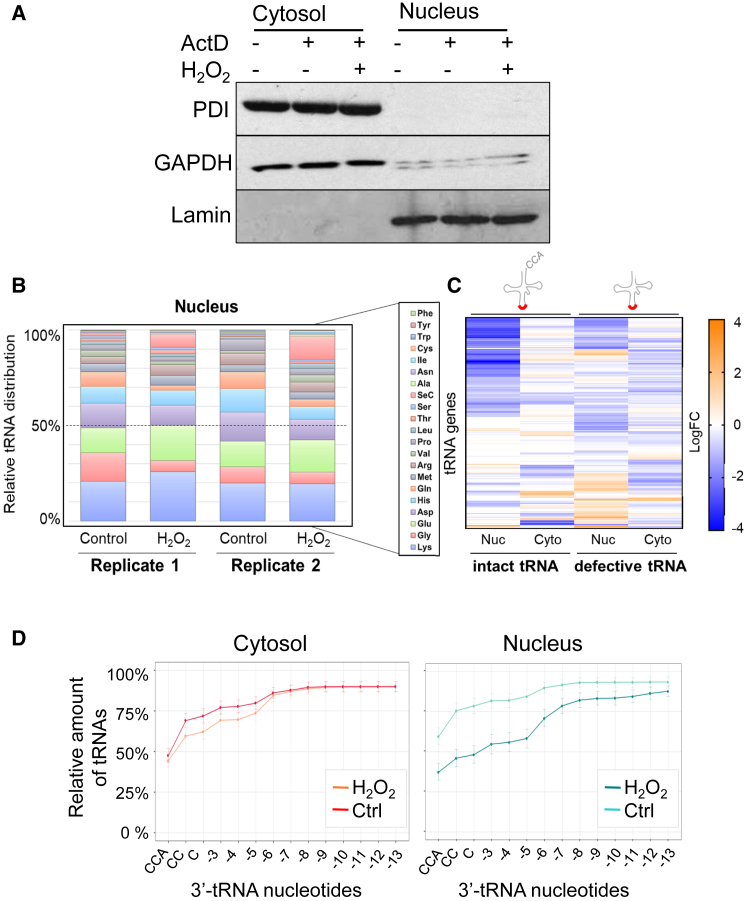
Oxidative Stress Induces Changes in the Overall Composition of the Cytosolic and Nuclear tRNA PoolsHeLa cells were treated with ActD in the presence or absence of 5 mM H2O2 for 2 h. Cells were fractionated into a nuclear and cytosolic fraction, RNA extracted from each fraction, and next-generation sequencing (TGIRT) of small RNAs was performed.(A) Western blot of nuclear and cytosolic fractions with antibodies detecting marker proteins for the nucleus and cytoplasm. GAPDH, glyceraldehyde 3-phosphate dehydrogenase; PDI, protein disulfide isomerase; lamin, lamin-B1.(B) Total RNA reads were mapped to 323 unique tRNA genes. All reads mapping to the same tRNA species were counted and combined, and their relative distribution was calculated. tRNAs were clustered according to their relative abundance in the nucleus.(C) Heatmap showing the Log2 fold change (Log2FC) of tRNA-specific reads in nuclear or cytoplasmic fractions of cells treated with H2O2 relative to untreated cells. tRNA-specific reads were mapped to the 3′ end of the tRNAs and sorted for intact tRNAs (with a full 3′ CCA end) and defective tRNAs (with an incomplete 3′ end). A threshold base mean of more than 20 reads was applied across all samples.(D) Cumulative abundance of intact or 3′ end-truncated tRNAs in the cytosolic and nuclear fractions upon treatment with H2O2. Sequencing reads were mapped to the 3′ end of the tRNAs at single-nucleotide resolution for the first 13 nucleotides. The relative amount of each tRNA species is shown for each missing nucleotide at the 3′ end.See also Figures S5 and S6 and Tables S2, S3, S4, and S5.